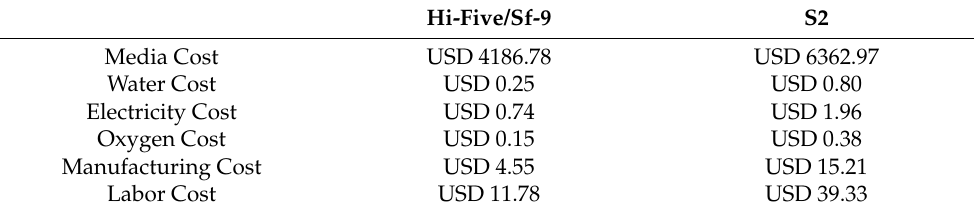
Table 2. Breakdown of cost of production per kilogram of insect cell-based